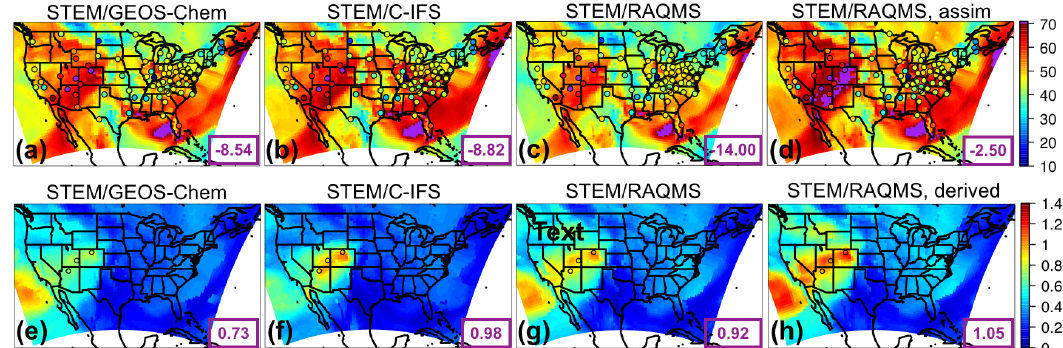
Figure 15. Case study of 9 May 2010: (a–d) Surface MDA8 total O 3 and (e–h) surface R (MDA8, EAS, 20%) from the STEM simulations using the (a, e) GEOS-Chem, (b, f) ECMWF C-IFS, and (c, g) RAQMS free run as the boundary conditions. (d) Surface MDA8 total O 3 in a STEM base simulation using the RAQMS assimilation run as the boundary conditions. CASTNET observations are overlaid in filled circles in (a–d) . (h) is 1 / 5 of the surface R (MDA8, EAS, 100%) from STEM/RAQMS simulations. The conditions at ∼ 400–500hPa are shown in Fig. S5. Purple numbers at the lower right corners of (a–d) and (e–h) are mean model biases and mean R (MDA8, EAS, 20%) values in ppbv at the three mountain sites (Grand Canyon NP, AZ; Canyonlands NP, UT; and Rocky Mountain NP, CO) where O 3 exceedances were observed on this day. The locations of these sites are shown in (e–h) as open